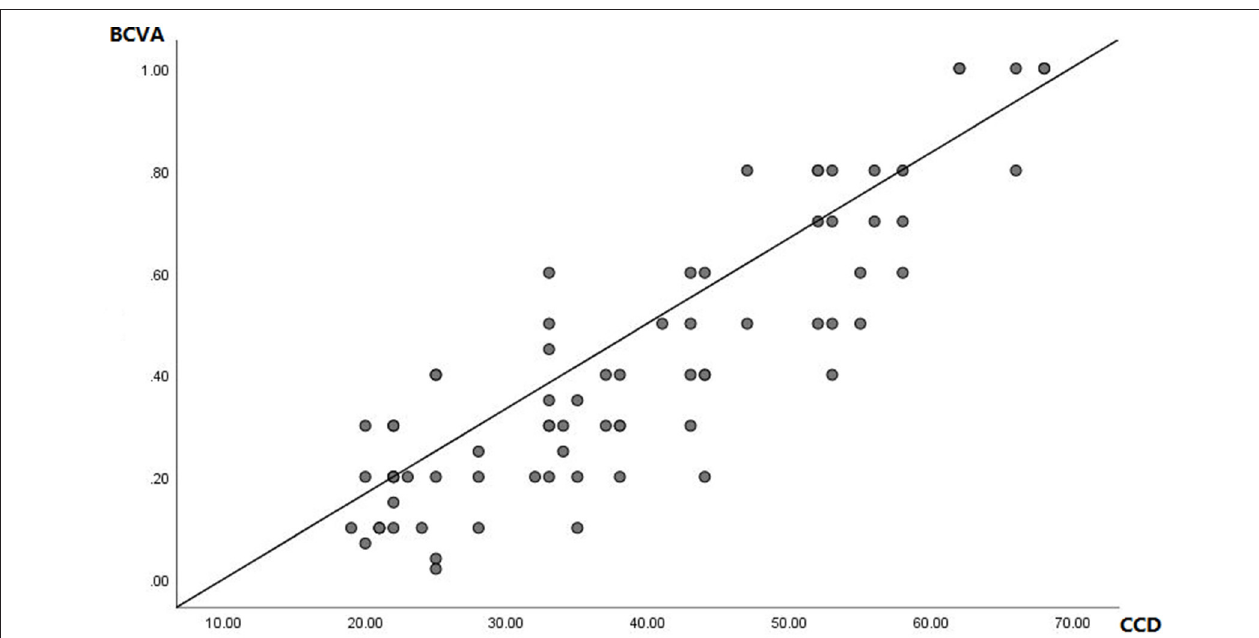
FIGURE 2 | Linear regression image comparing the prognosis changes of CCD and BCVA. y = 0.0167* x + − 0.1667, r = 0.878; p < 0.001.